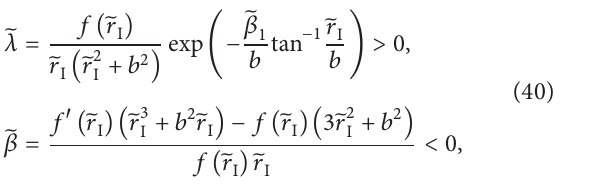
Figure14:Sketchesof 𝑓 󸀠 (𝑟) (blue), ℎ 󸀠 1 (𝑟) = 𝜆 1 (3𝑟 2 + 𝛽 1 𝑟 + 𝑏 2 ) exp ((𝛽 1 /𝑏) tan −1 (𝑟/𝑏)) (green),and ℎ 󸀠 2 (𝑟) = 𝜆 2 (3𝑟 2 +𝛽 2 𝑟+𝑏 2 ) exp ((𝛽 2 /𝑏) tan −1 (𝑟/𝑏)) (red). The dashed purple (a) and dashed pink (b) curves represent parameters, ( 𝛽 1 <